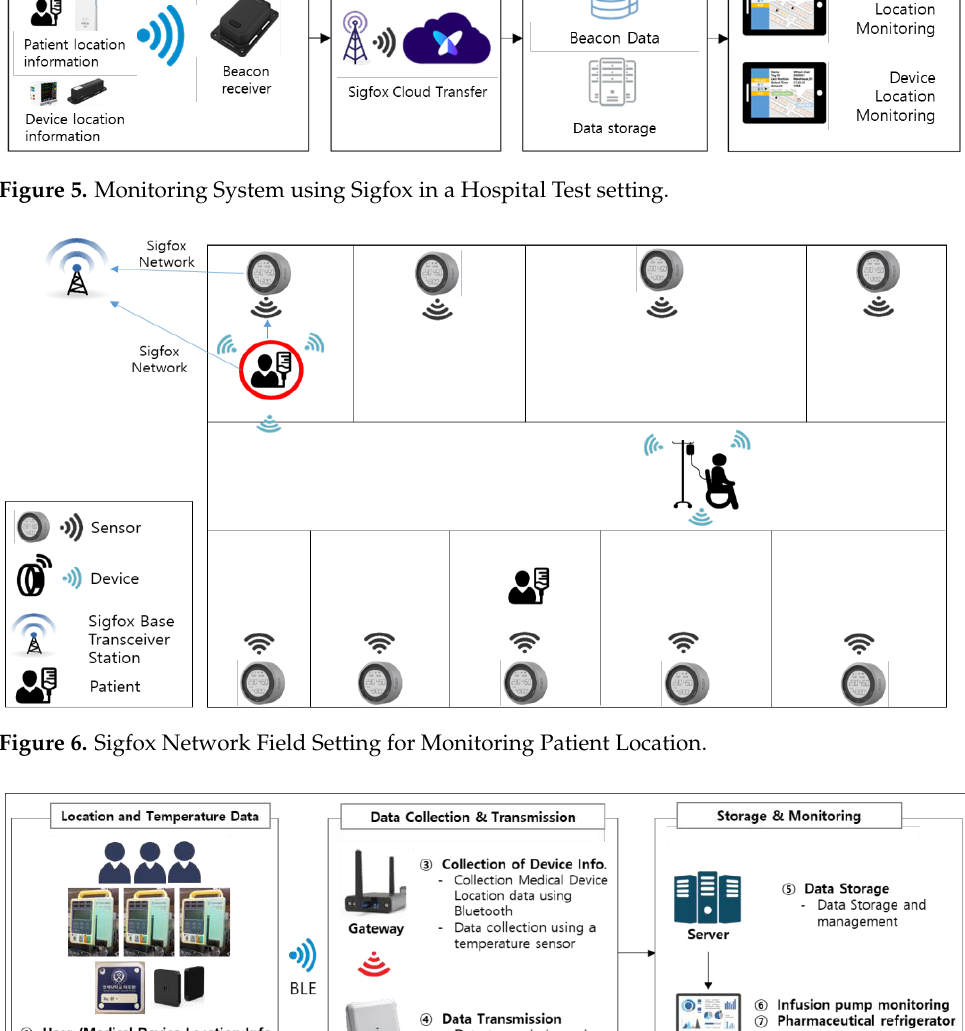
Figure 7. Hospital Monitoring System.